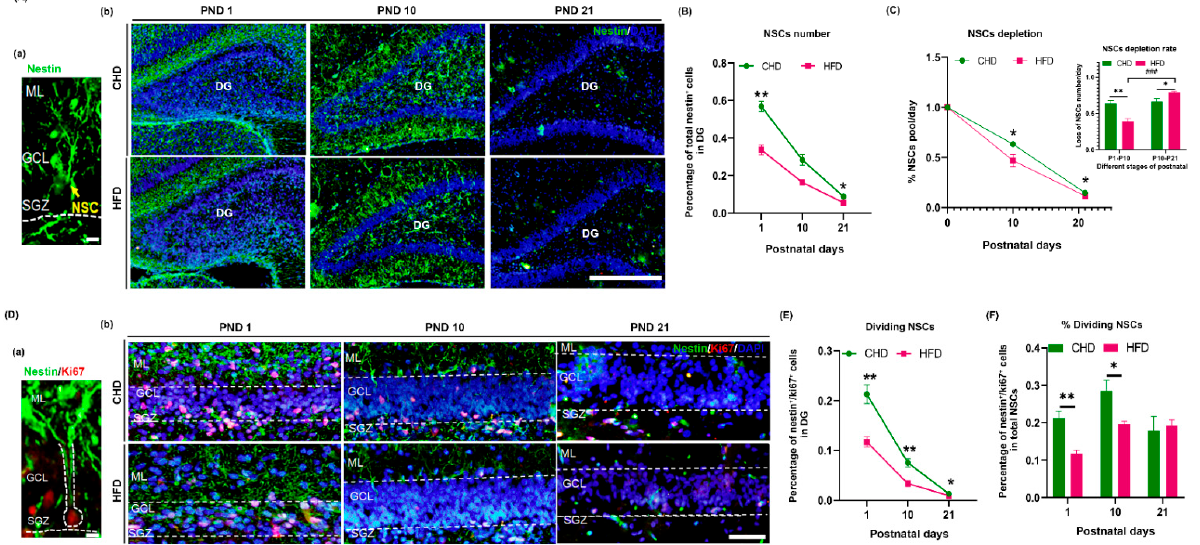
Figure 3. Maternal HFD reduced NSC proliferation during DG development. ( A ) Changes in NSC number on PND 1, PND 10 and PND 21; morphology of radial NSCs (Nestin + ) (a), scale bar = 200 µ m; Nestin (green) immunostaining (b), scale bar = 50 µ m. ( B ) Quantification of NSCs number on PND 1, PND 10 and PND 21 ( n = 3). ( C ) The rate of NSC depletion on PND 1 ( n = 3), PND 10 ( n = 5) and PND 21 ( n = 4). ( D ) Changes in proliferating NSC number on PND 1, PND 10 and PND 21; proliferation of radial NSCs morphology (Nestin + /Ki67 + ) (a), scale bar = 200 µ m; Nestin (green)/Ki67 (red) immunostaining in GCL (b), scale bar = 50 µ m. ( E ) Quantification of Ki67 + dividing NSCs on PND 1 ( n = 3), PND 10 ( n = 3) and PND 21 ( n = 4). ( F ) Percentage of Ki67 + dividing NSCs out of total NSCs. * p < 0.05, ** p < 0.01, vs. CHD; ### p < 0.001 vs. postnatal days. DG, dentate gyrus; NSCs, neural stem cells; ML, molecular layer; GCL, granular cell layer; SGZ, subventricular zone; PND, postnatal